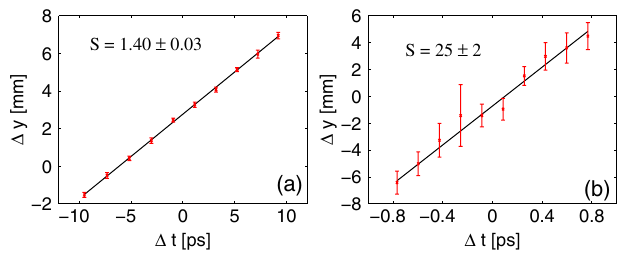
FIG. 2. (Color) Vertical beam position on the screen OTR1 as a function of (cid:1) t , the time delay between bunch arrival and zero- crossing phase of the TDS. (a) Low rf power, the shear parameter derived from this calibration is S ¼ 1 : 40 (cid:2) 0 : 03 ; (b) high rf power, S ¼ 25 (cid:2) 2